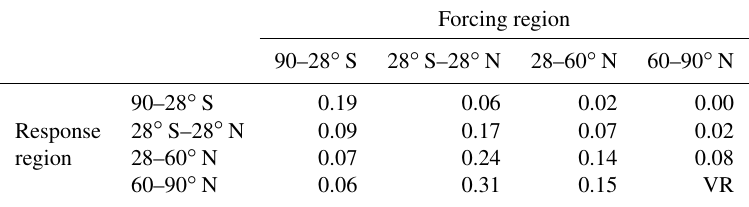
Table B1. Regional climate sensitivity coefficients employed in Eq. (B1) for BC direct radiative forcing (K(Wm − 2 ) − 1 ).